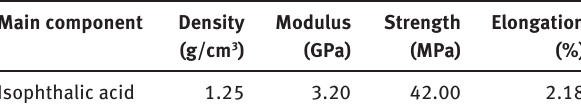
Table 1 Properties of unsaturated polyester